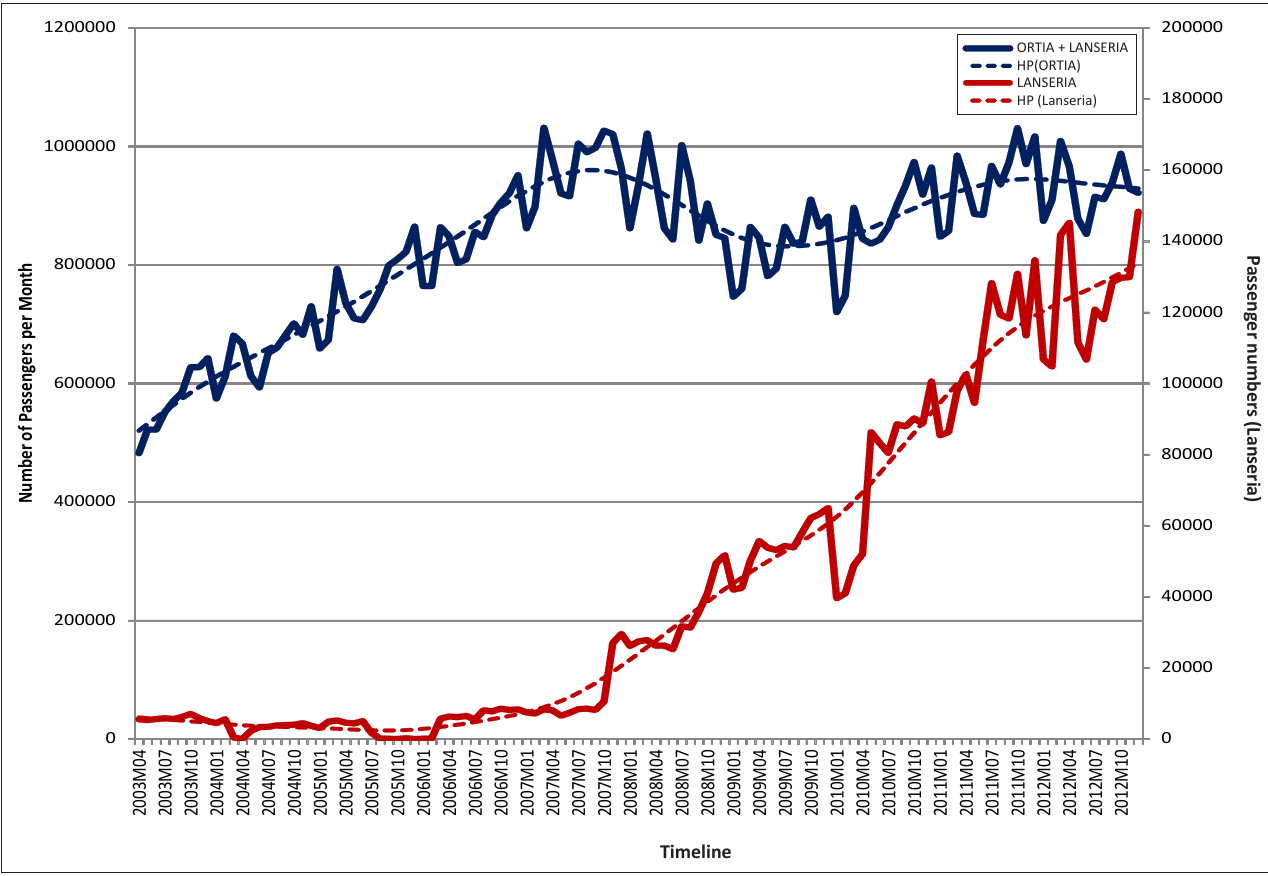
FIGURE 5: Passenger trends at Oliver Reginald Tambo International and Lanseria International airports (total scheduled arrivals and departures).